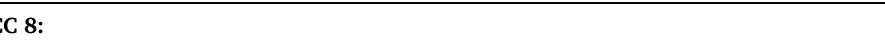
Fuhr and Stensæth. Voices 2022, 22(3).